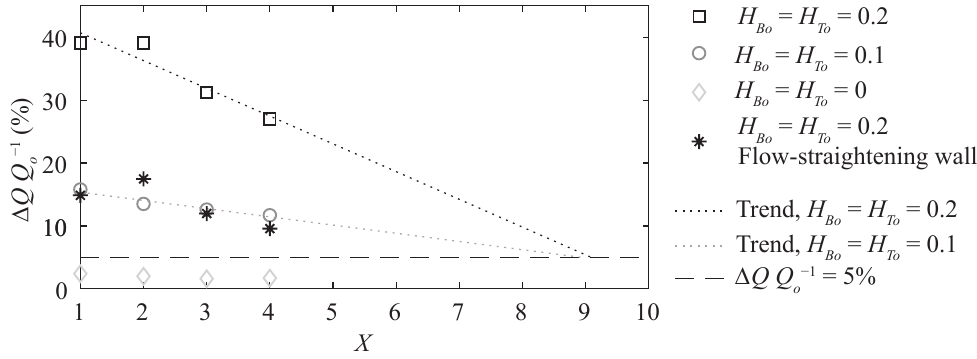
Figure 11. Development of ∆ QQ o − 1 along the x-axis of the configuration S4, α = 45 ◦ , s b = 20 mm for di ff erent overlay